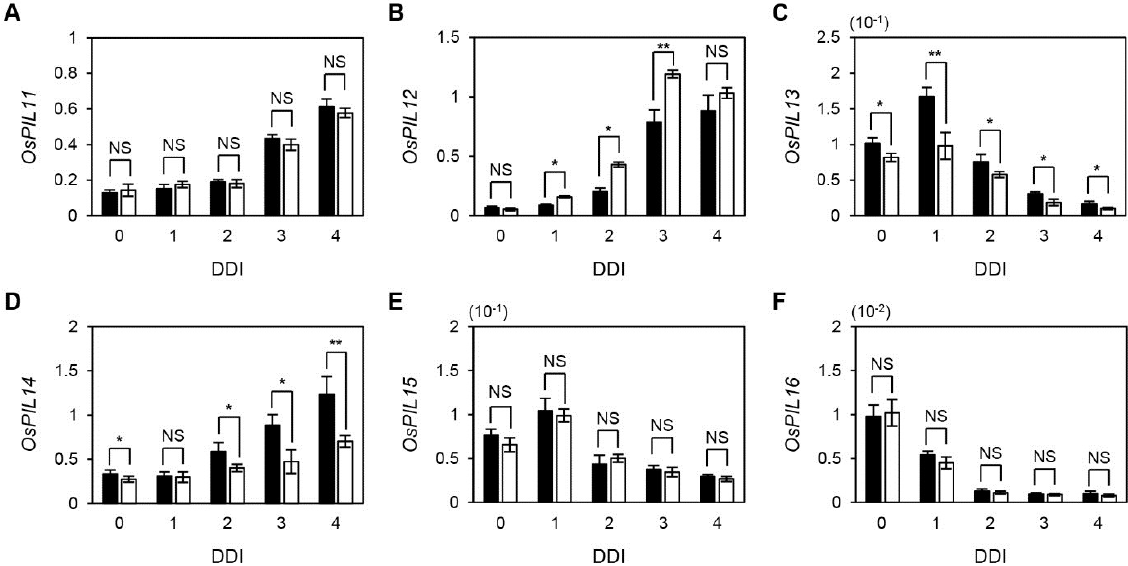
Figure 6. Expression of six rice PIF genes during DIS. Detached leaf segments from one-month-old WT and osphyB-2 plants grown under LD conditions were incubated on the 3 mM MES (pH 5.8) buffer with the abaxial side up at 28 °C in darkness, and were sampled at 0 to 4 DDI for RT-qPCR. RT-qPCR was used to measure the relative transcript levels of OsPIL11 ( A ); OsPIL12 ( B ); OsPIL13 ( C ); OsPIL14 ( D ); OsPIL15 ( E ); and OsPIL16 ( F ); and transcript levels were normalized to the transcript levels of OsUBQ5 . Black and white bars indicate WT and osphyB-2 , respectively. Mean and SD values were obtained from more than three biological replicates. Asterisks indicate significant difference between WT and osphyB-2 (Student’s t -test p values, * p < 0.05; ** p < 0.01). These experiments were repeated twice with similar results. DDI, day(s) of dark incubation; NS, not